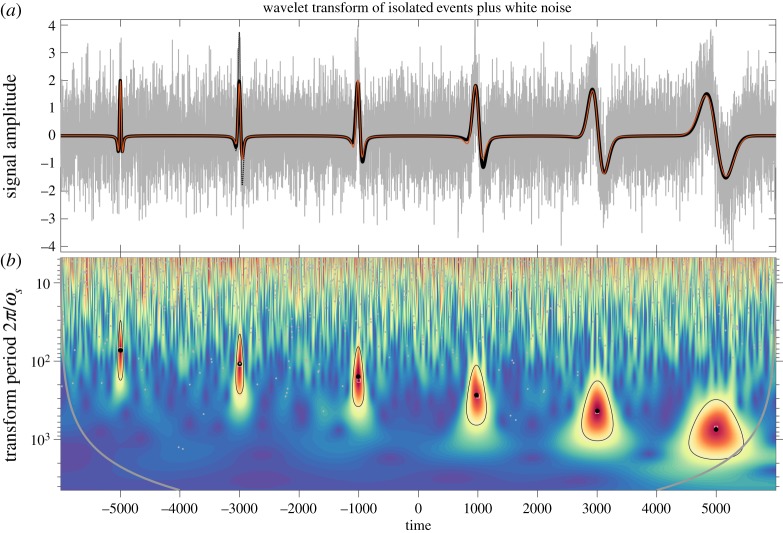
An illustration of signal reconstruction using element analysis applied to a synthetic signal in noise. A 12000 point signal (a) consisting of a series of six impulsive events, constructed from a ψ1,2(t) wavelet as described in the text, is shown as the heavy black line. This signal is added to a realization of unit-variance Gaussian white noise, resulting in the grey line. The wavelet transform of this noisy signal with a ψ2,2(t) wavelet is shown in (b), in which the y-axis shows the transform period 2π/ωs on a logarithmic scale. Black circles mark the locations of six statistically significant and isolated maxima, identified as described in the text, while grey dots mark the locations of all other transform maxima. The locations of the six significant maxima in the absence of noise are shown with grey squares, but these are usually not visible because they are overlapped by the black circles. The heavy grey curves in (b) denote locations that are contaminated by edge effects, defined as time-scale locations within an interval Lβ,γ(s)/2=2Pβ,γωs from the beginning or the end of the time series. Black lines delineate the λ=1/2 region of influence around each maximum, as defined later in §4d. In (a), the red line shows the reconstruction based on statistically the six significant and isolated maxima, which is seen to be virtually identical to the original. The dotted line shows a reconstruction that does not taken into account the isolation criteria for the maxima, resulting in misfit near the second event; this line is elsewhere obscured by the red line.